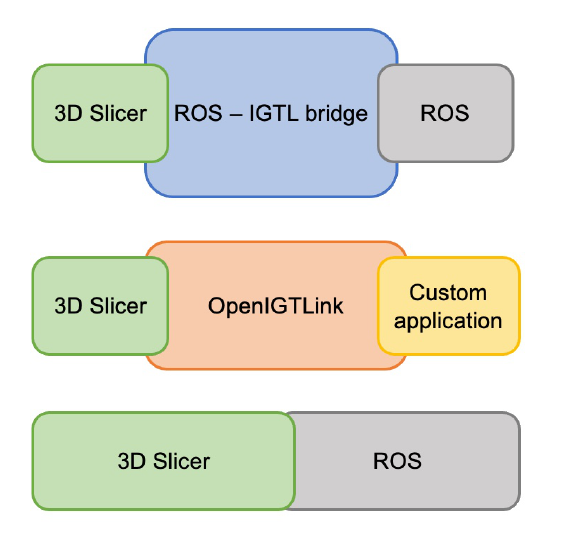
Figure 1. Comparison of existing methods to bridge ROS and 3D Slicer. ( Top ) ROS-IGTL bridge configuration. ( Middle ) OmniIGT configuration. ( Bottom ) Proposed SlicerROS2